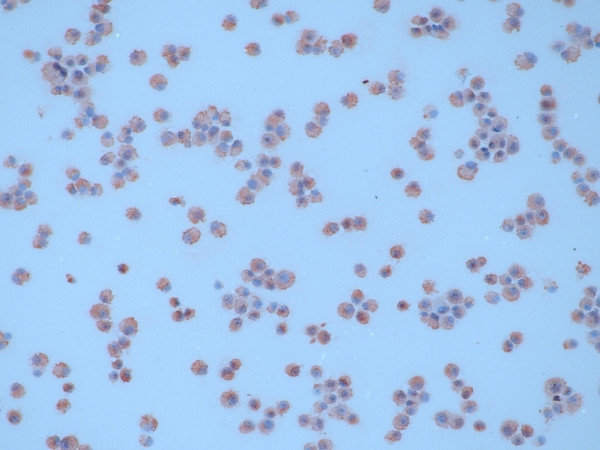
Cytospin of cell line MAZ immunostained with mAb SM5-1. Immunohistochemical staining (cytospin) of MAZ cells with mAb SM5-1.